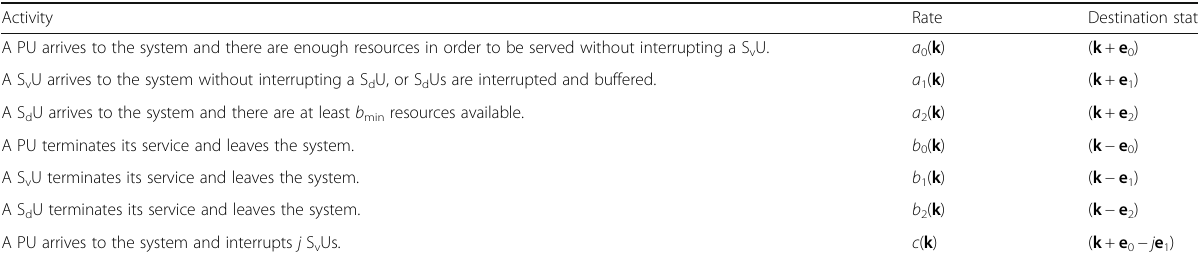
Table 3 Transitions from a reference state k = [ k 0 , … , k 2 ] Activity Rate Destination